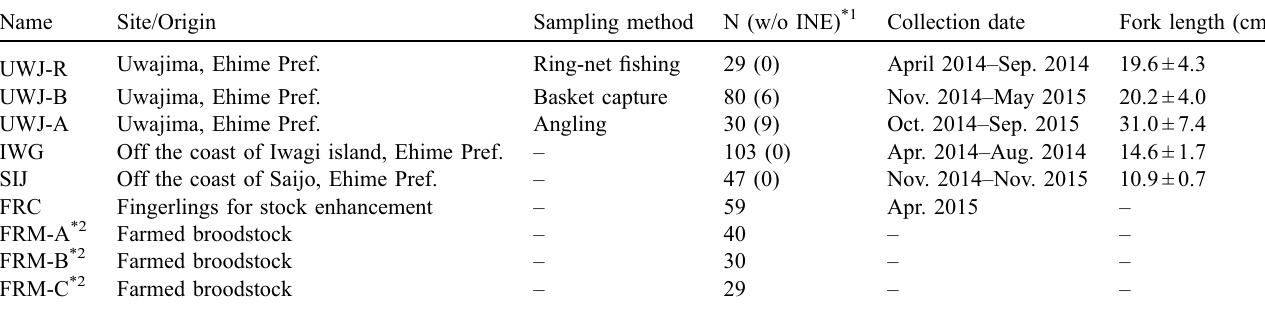
Table 1. Location, sampling method used, and other details of the populations used in the